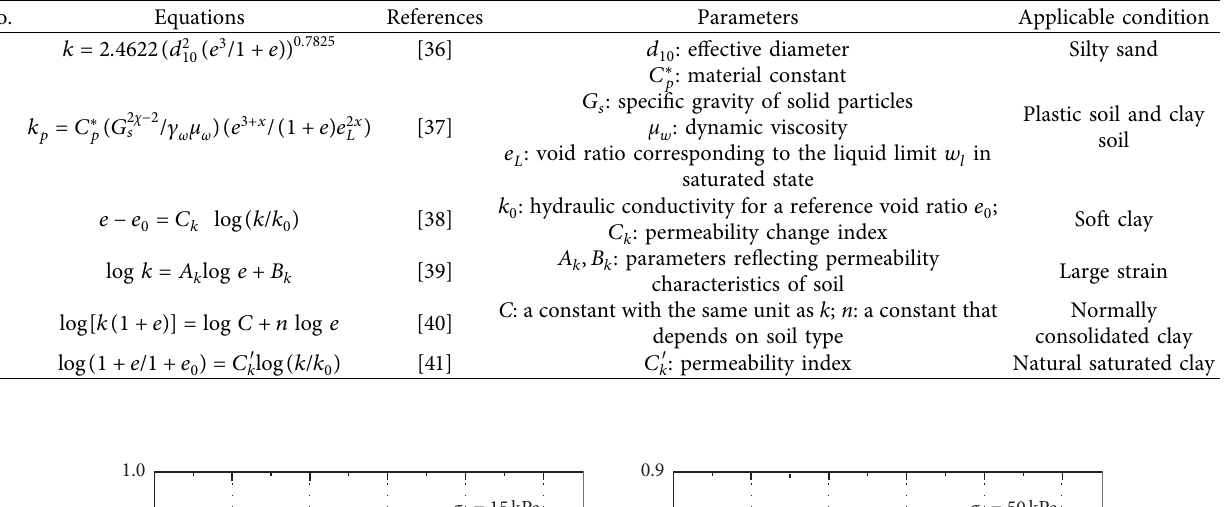
Table 2: Typical permeability